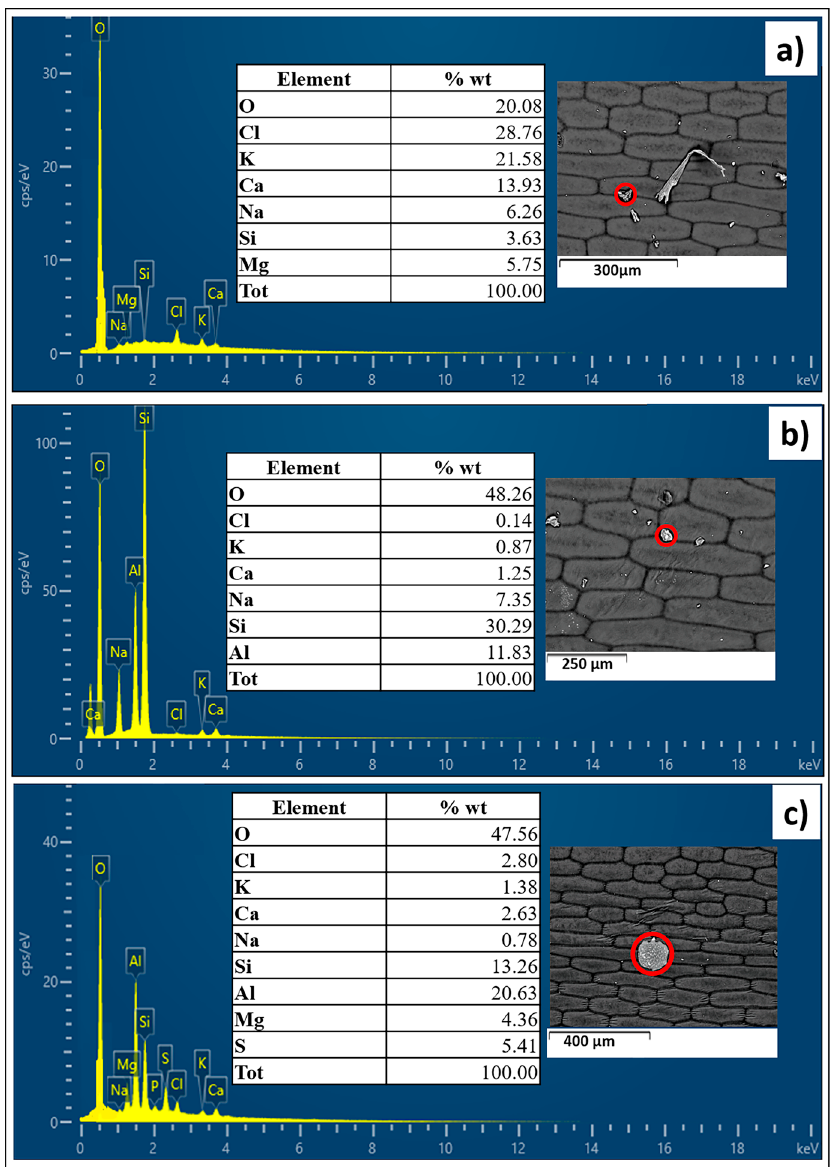
Figure 6. EDS analyses ( a – c ) acquired on single particles present on the leaves’ surfaces and evidenced with a red circles in ( a – c ).